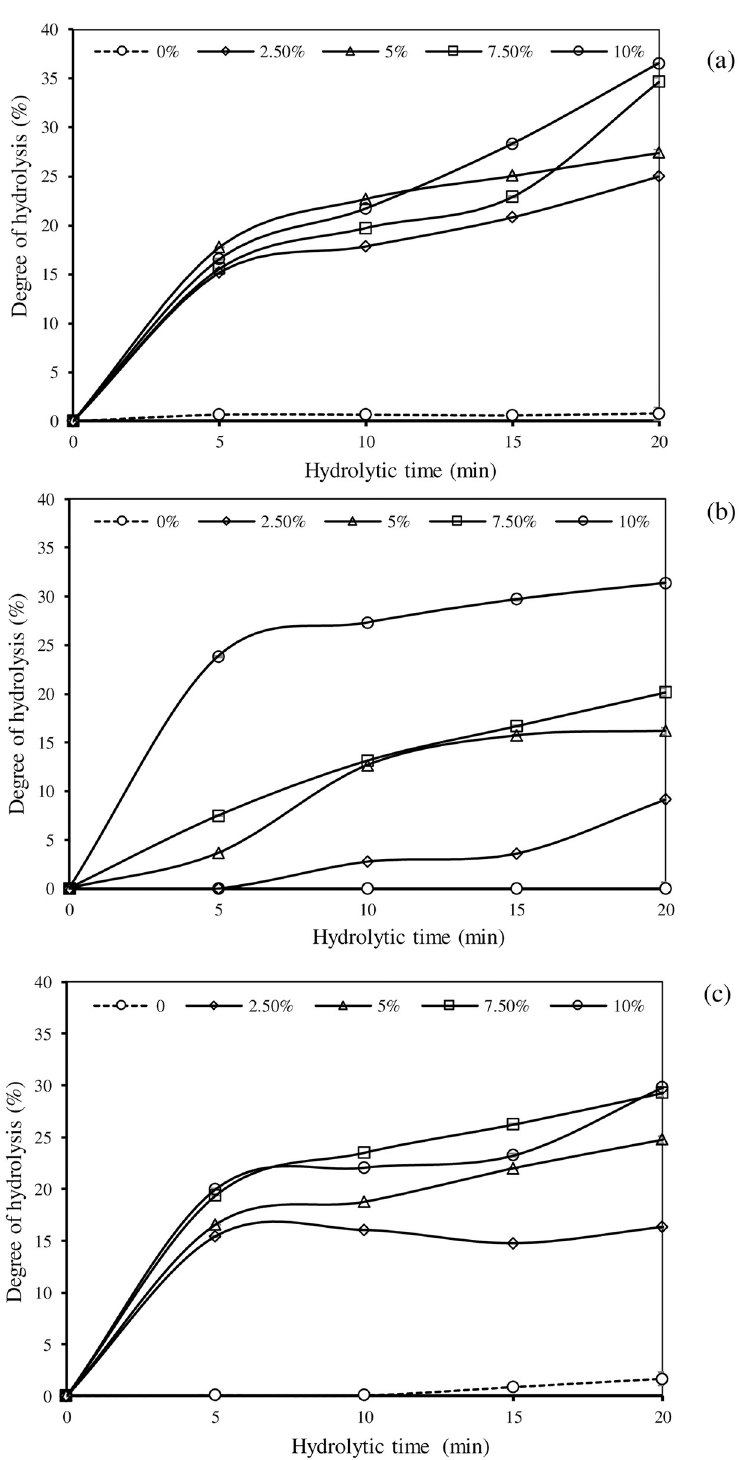
Fig 1. Effects of enzyme type (Alcalase (a), Flavourzyme (b), and papain (c)), enzyme concentration, and hydrolysis time on the degree of hydrolysis (DH) of porcine placenta protein. Bars represent standard deviation from triplicate